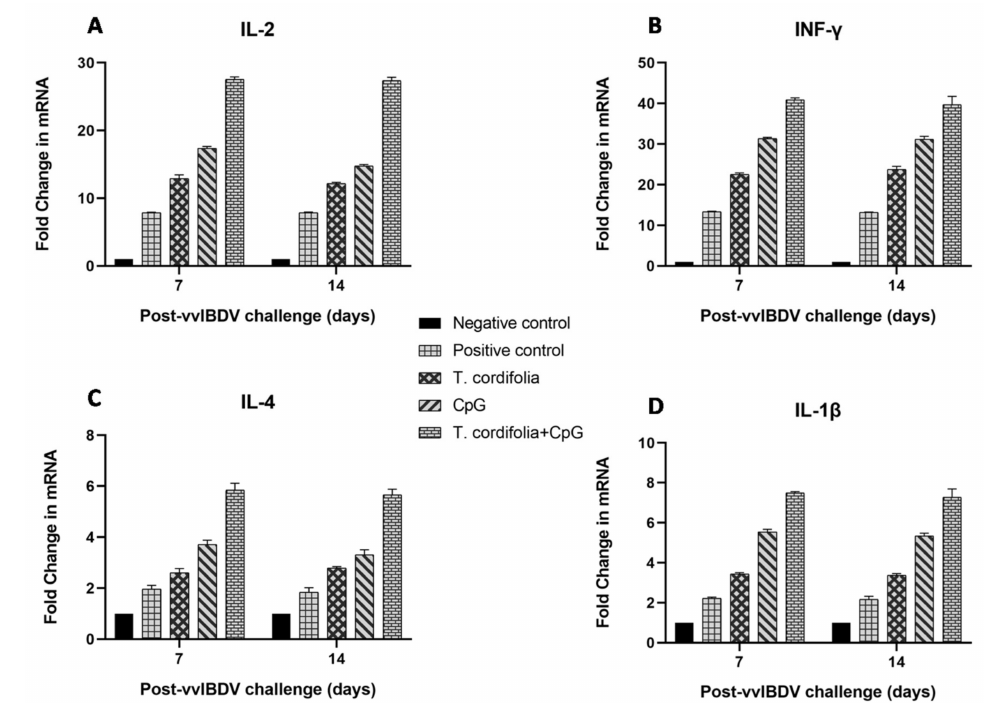
Figure 3. ( A – D ). Quantitative real-time PCR analysis of immune response gene transcripts in the bursa of Fabricius ex vivo, in SPF WL chickens 7 and 14 days post-vvIBDV challenge. The results are expressed as fold changes to the immune response gene transcripts relative to the control group.